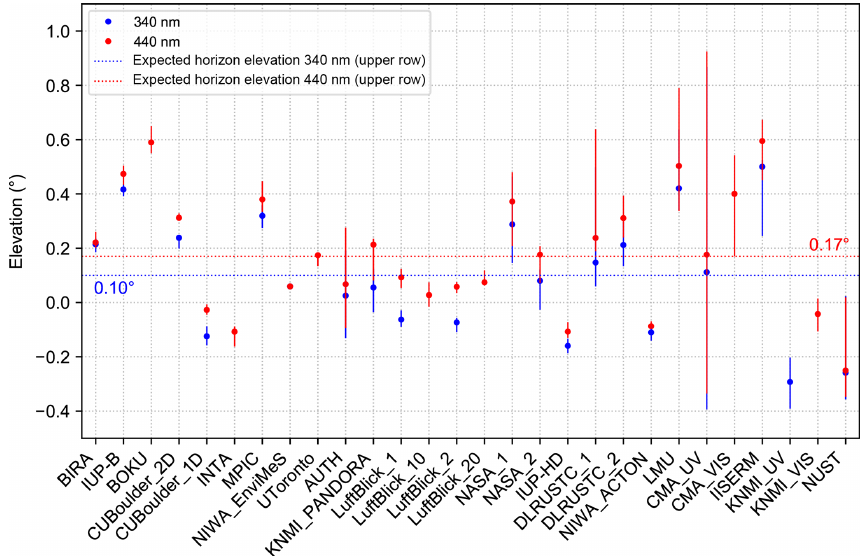
Figure 15. Overview of the retrieved median horizon elevations for all participating instruments at the two different wavelengths. Addition- ally, the 25th and 75th percentiles are indicated by the lines.